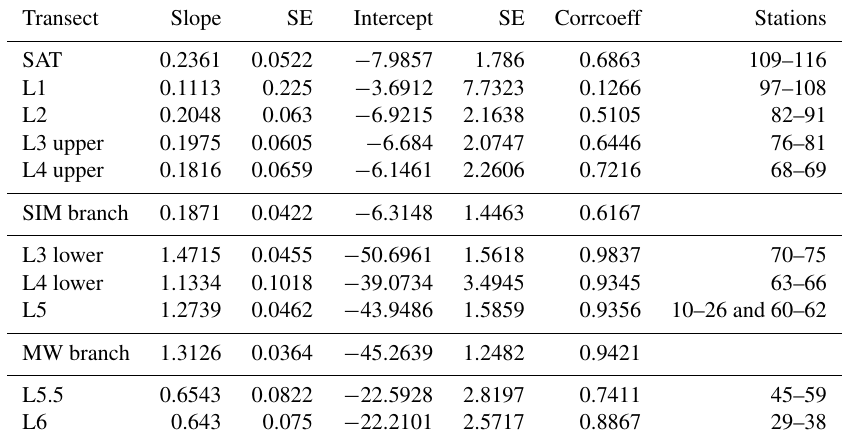
Table 2. Linear regression analyses (restricted to the salinity range: 34 ≤ S <34.5) of salinity– δ 18 O measurements collected along transects occupied during the 2013. Slopes, intercepts, correlation coefficients ( r ) and associated standard errors (SEs) are reported for each transect as well as the collection of transects comprising the sea-ice melt (SIM) and meteoric (MW) water branches. Transect Slope